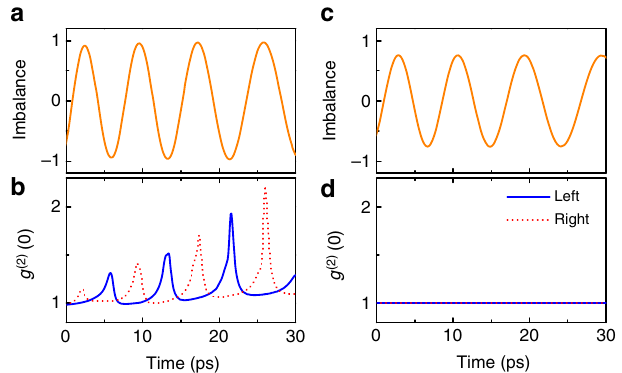
Fig. 4 Role of nonlinearity. a Population imbalance and b second-order correlation function for interparticle interactions U = 1.4 μ eV. c , d Same, but for U = 0. Other simulation parameters are given in